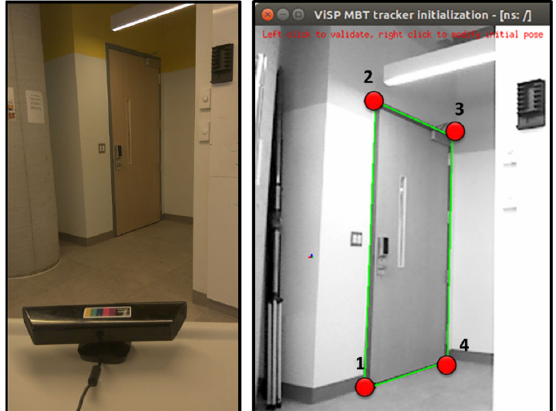
Figure 9: Initializing ViSP in the first experiment using the 4 corners of the door to the BEST lab. The 3D wireframe model of the door is projected onto the image (green lines) using the estimated camera